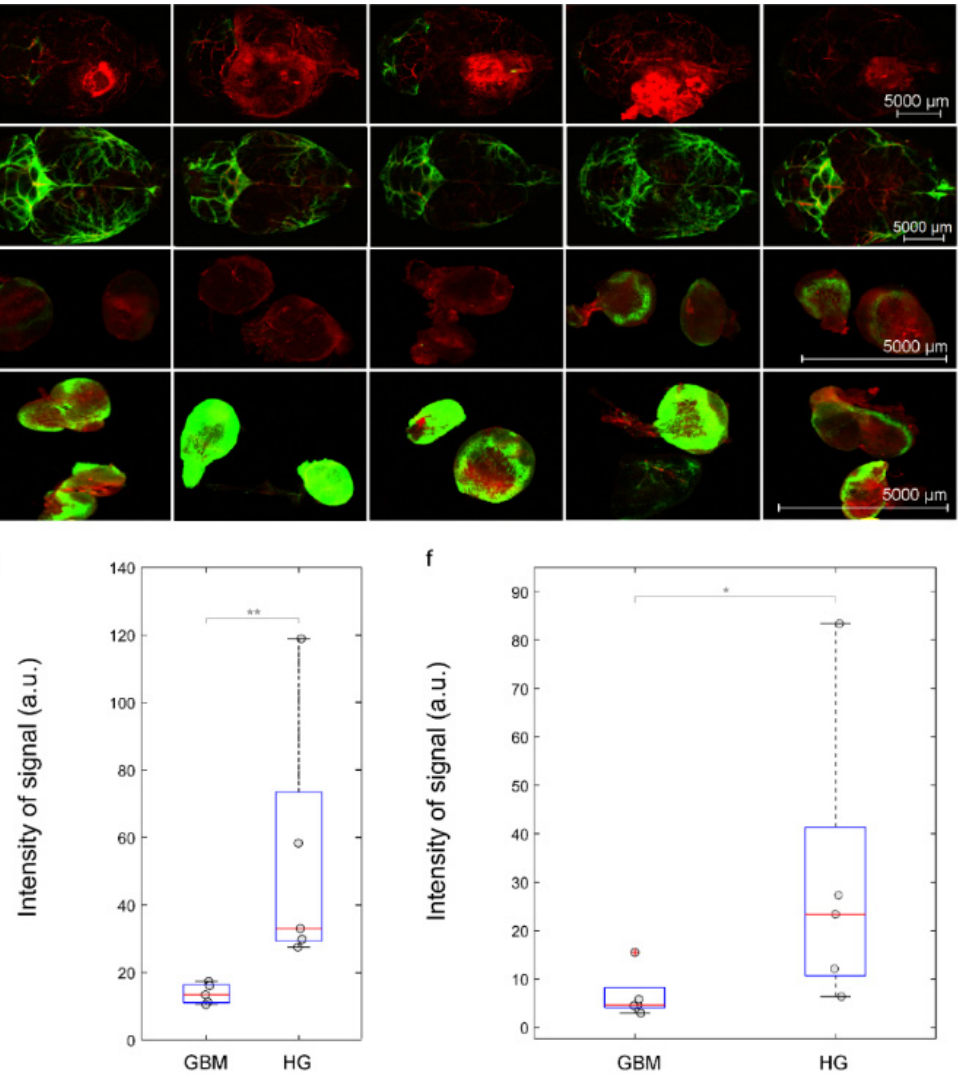
Figure 3. The GBM (red, λ ex = 555 nm) is characterized by reducing intranasal delivery of liposomes to the brain and their removal to the dcLNs: ( a )–( d ) representative confocal images of liposomes (green) spreading in dorsal part of the brain and their accumulation in the dcLN in the GBM group ( a , c ) and in the HP ( b , d ), the blood vessels were filled with Evans Blue (red, λ ex = 640 nm); the quantitative analysis of fluorescent signal from liposomes (a.u.) in the brain ( e ) and in the dcLNs ( f ) in the GBM group and in the HG groups, n = 5 in each group, * p < 0.05, and ** p < 0.01 the Mann–Whitney–Wilcoxon test, the outliers of experimental data are plotted using the + symbol.